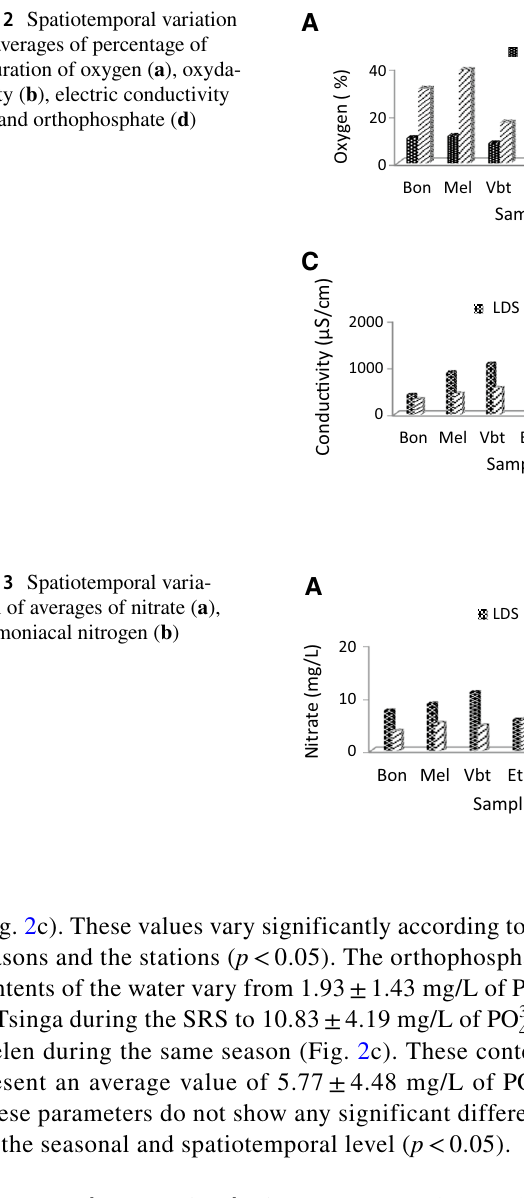
Fig. 2 Spatiotemporal variation of averages of percentage of saturation of oxygen ( a ), oxyda- bility ( b ), electric conductivity ( c ) and orthophosphate ( d )